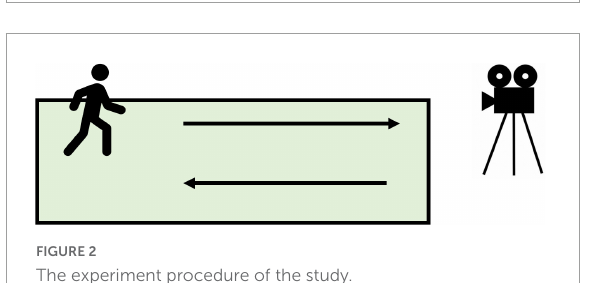
FIGURE1 The 25 joints captured by the BODY25 model.